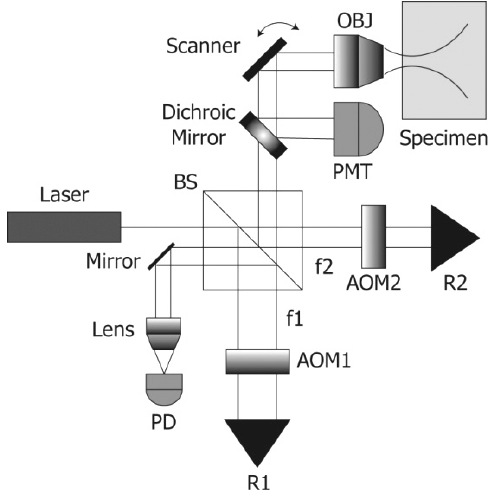
Fig. 10. A STPM comprised of two